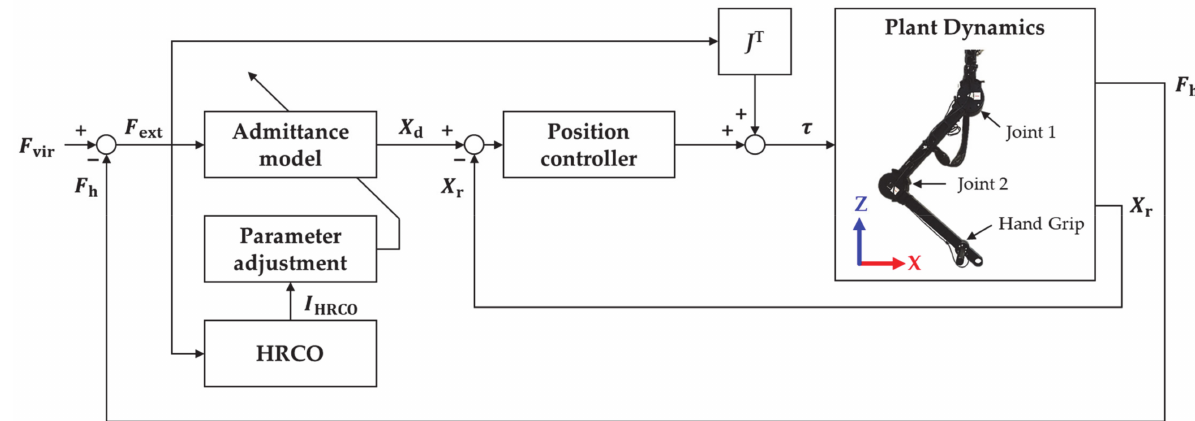
Figure 7. Block diagram of variable admittance control based on